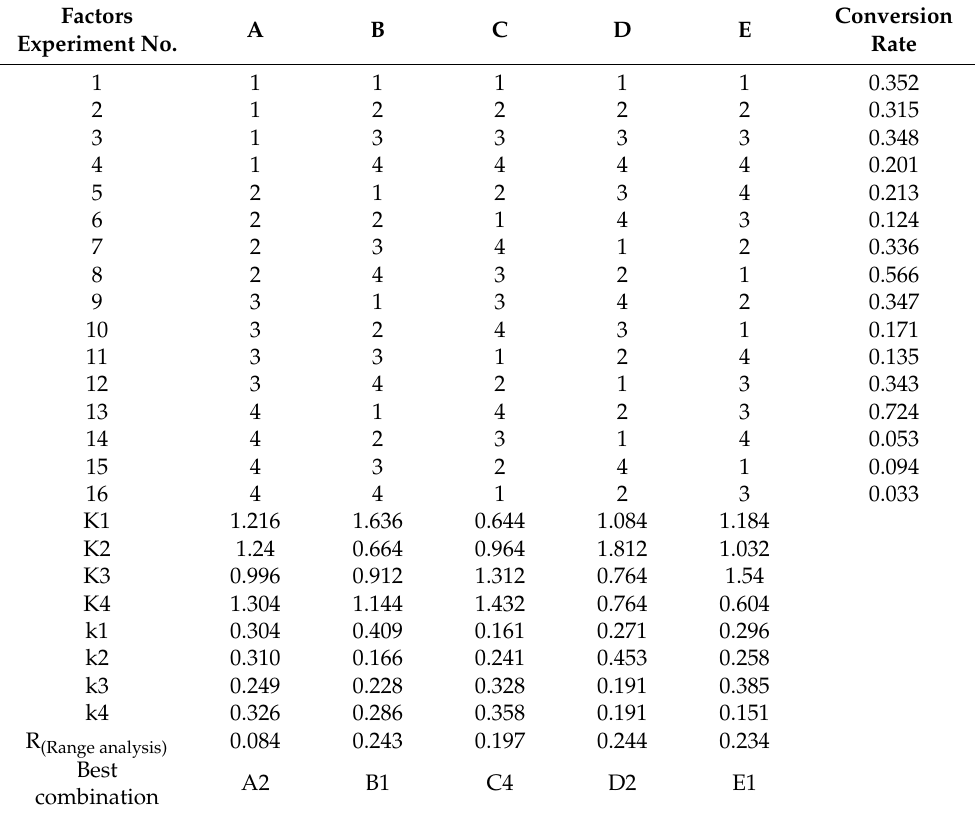
Table 2. Orthogonal experimental results and